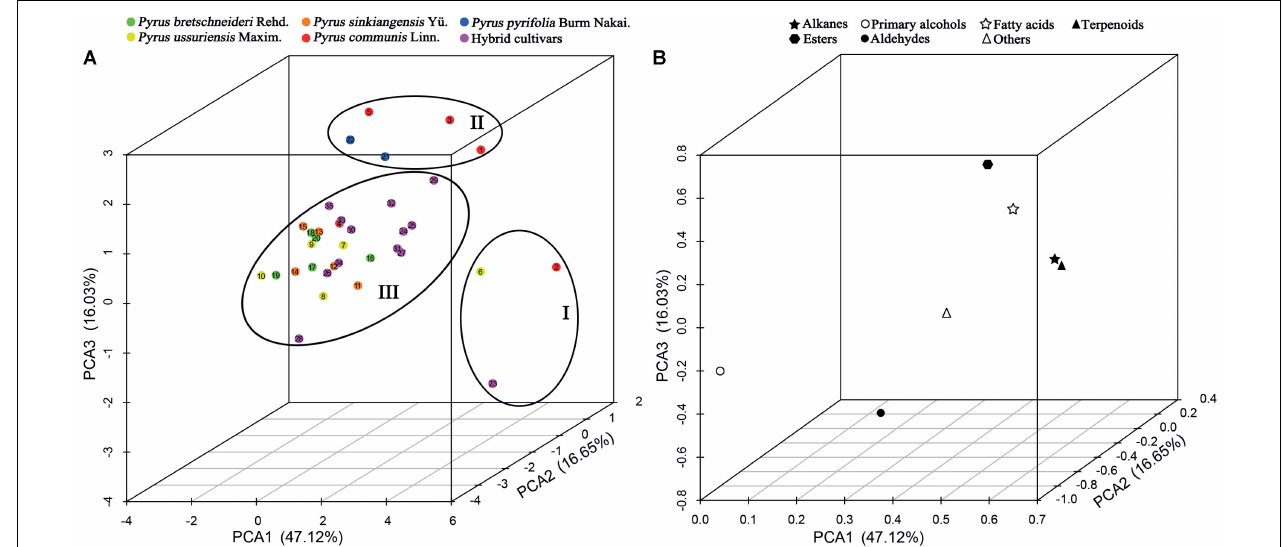
FIGURE 5 | PCA of seven main classes of wax compounds in 35 pear cultivars. (A) Scatter plot of PCA scores and (B) loadings plot of the PCA. The numbers in (A) correspond to the sample numbers given in Table 1 . Percentages in parentheses are the variance of each component.